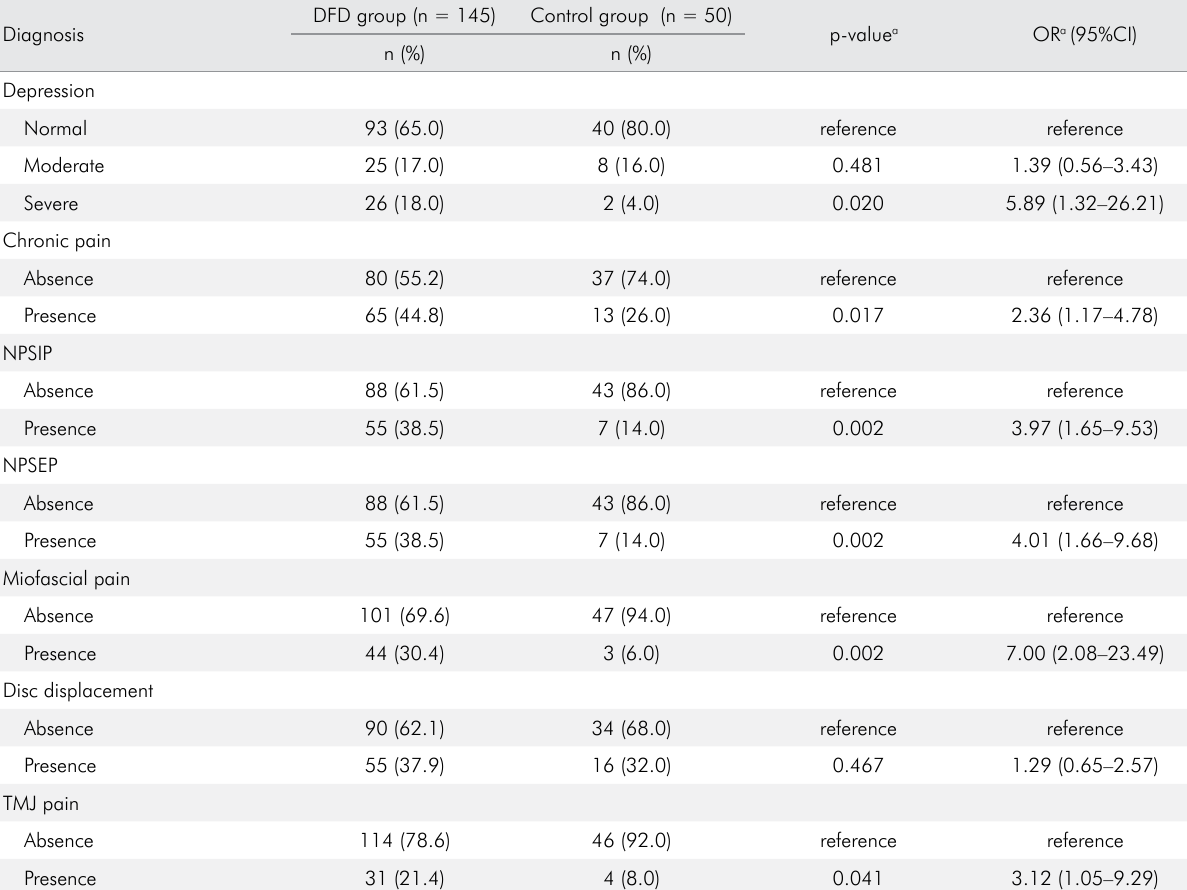
Table 2. Comparison of RDC/TMD diagnoses between individuals with dentofacial deformities (DFD) and control group. DFD group (n = Diagnosis